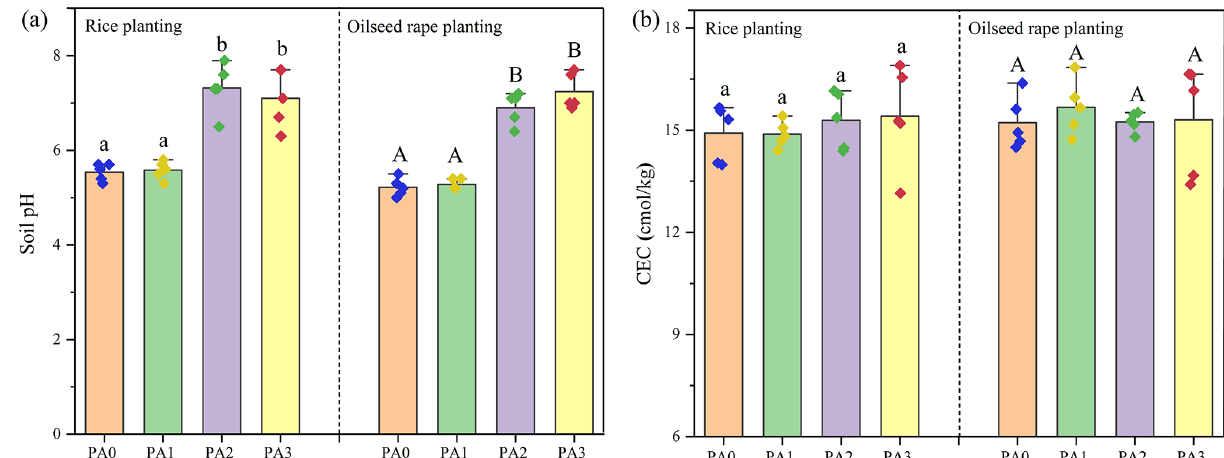
Figure 5. The effects of different amendments on soil pH (a) and CEC (b) . Dots represent the value of each sample. Bars followed with different lowercase letters (a–c) and capital letters (A and B) indicate the significant ( p ≤ 0 . 05) difference among different treatments in rice planting and oilseed rape planting according to the LSD test. Values represent means ± standard